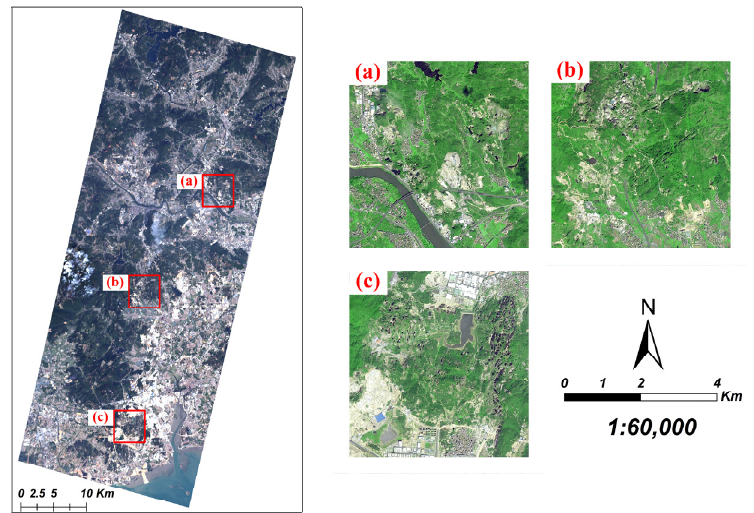
Figure 12. Locations and high resolution images (from Gaofen-2 satellite) of 3 selected areas used for visual verification: ( a ) Northern mineral exploiting area, ( b ) Middle mineral exploiting area, ( c ) Southern mineral exploiting area.